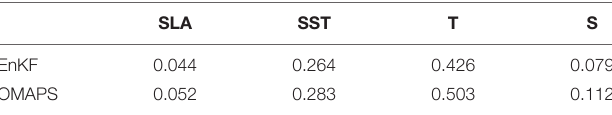
TABLE 2 | Performance summary table of a BlueLink ensemble Kalman filter hindcast compared with the current OceanMAPS system using ensemble optimal interpolation. SLA SST T S EnKF 0.044 0.264 0.426 0.079 OMAPS 0.052 0.283 0.503